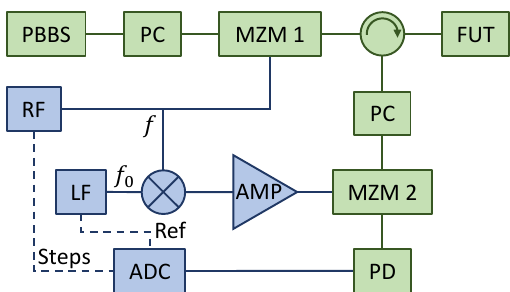
Figure 3. System setup. ADC, analog-to-digital converter; AMP, RF amplifier; LF, low-frequency signal generator; FUT, fiber under test; MZM, Mach–Zehnder modulator; PBBS, polarized broadband source; PC, polarization controller; PD, photodiode; RF, stepped RF source. Dashed lines stand for TTL signaling indicating RF steps (Steps) and reference tone